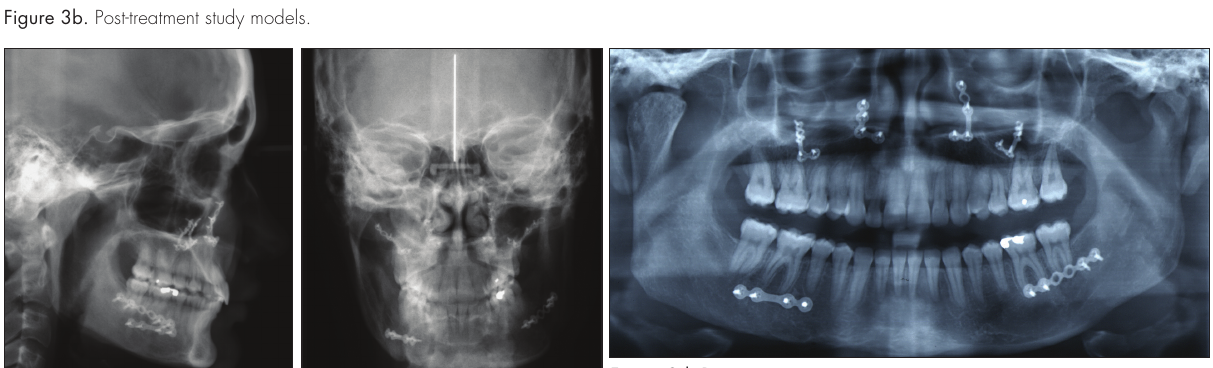
Figure 3b. Post-treatment study